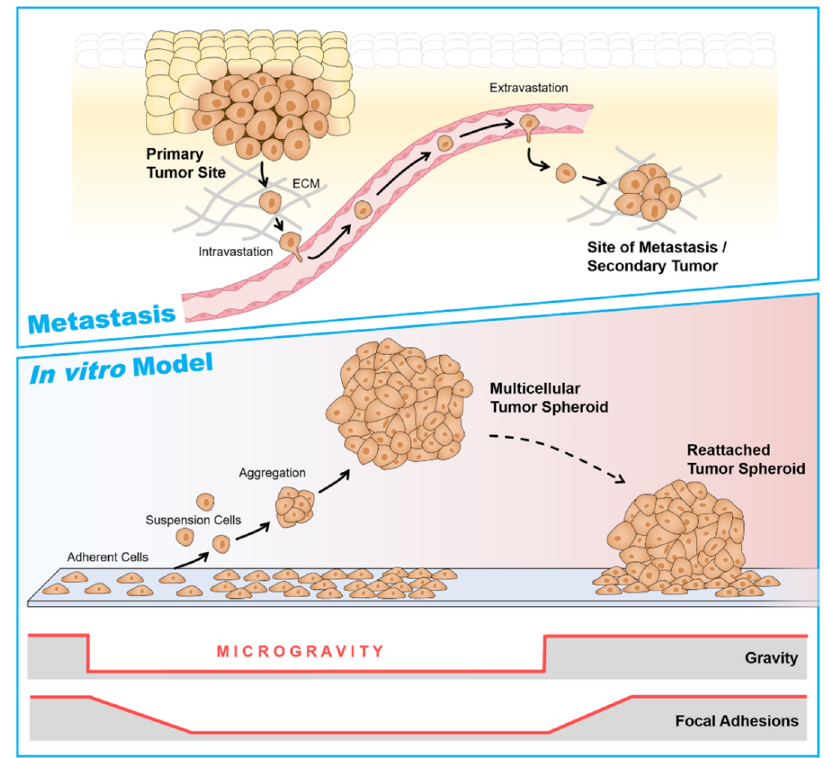
Figure 5. Schematic representation of the µ g -induced in vitro metastasis model. When exposed to µ g , adherent cancer cells downregulate focal adhesions. The cells detach and micro-metastasis-like tumor spheroids are formed. When gravity is restored, the spheroids reattach on their